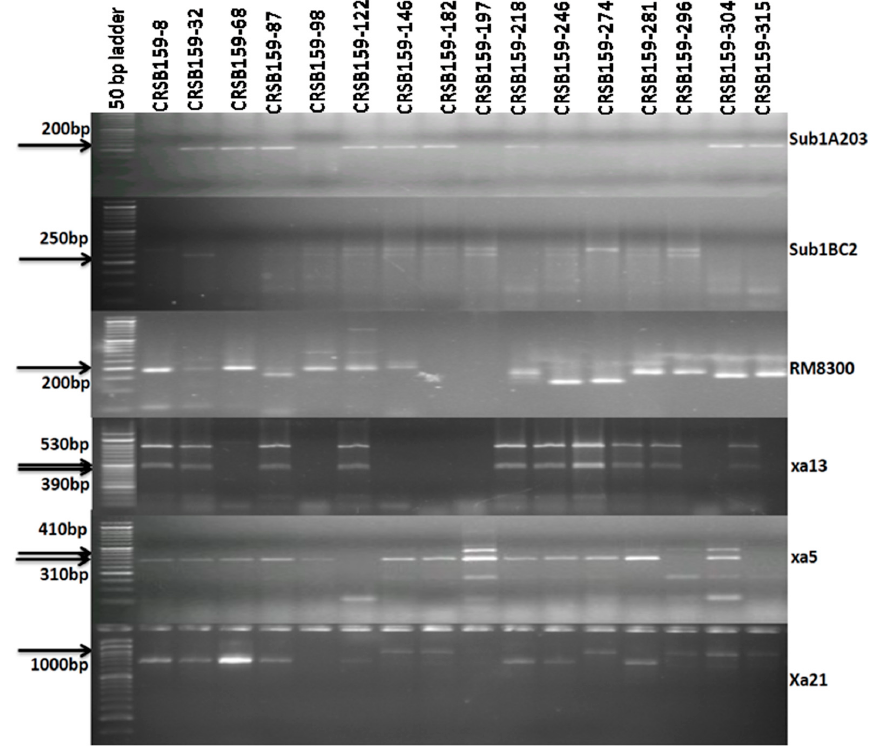
Figure 4. Representative electropherogram of BC 2 F 1 -derived lines of Ranidhan using submergence tolerance markers (Sub1 BC2 and Sub1A203 ) and markers for bacterial blight resistance genes Xa21 , xa13 , and xa5 . The numbers at the top indicate the BC 1 F 1 generation of Ranidhan-derived lines. A50 bp DNA ladder was used.